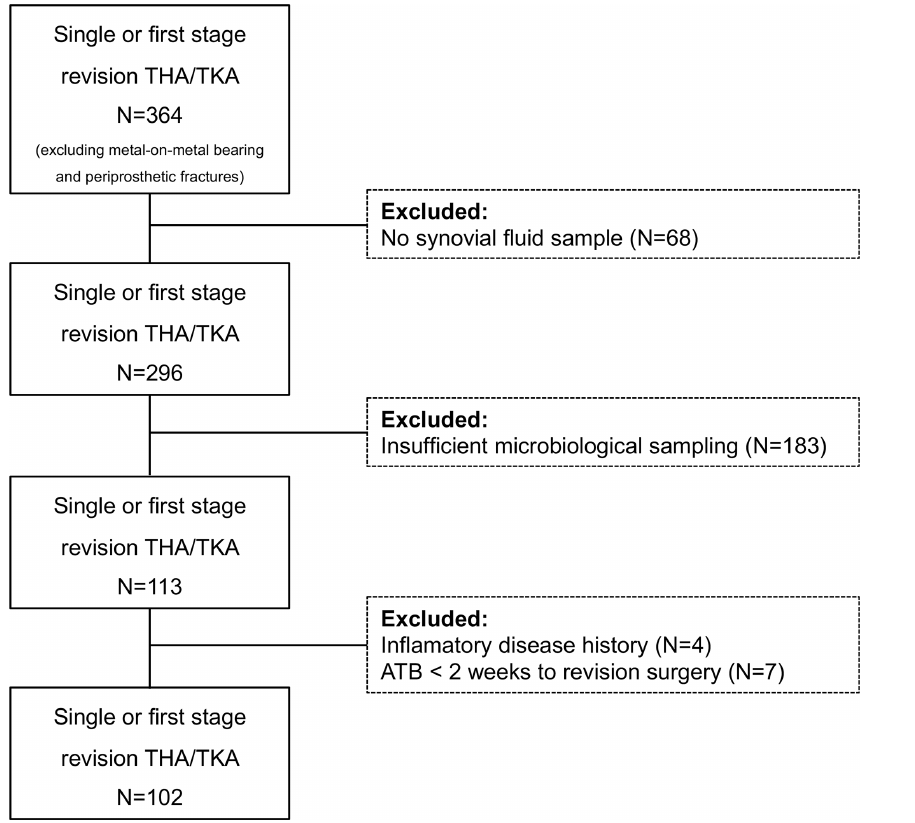
Figure 1. Flowchart of inclusion criteria. Table 1. Demographic and clinical information of the patients a